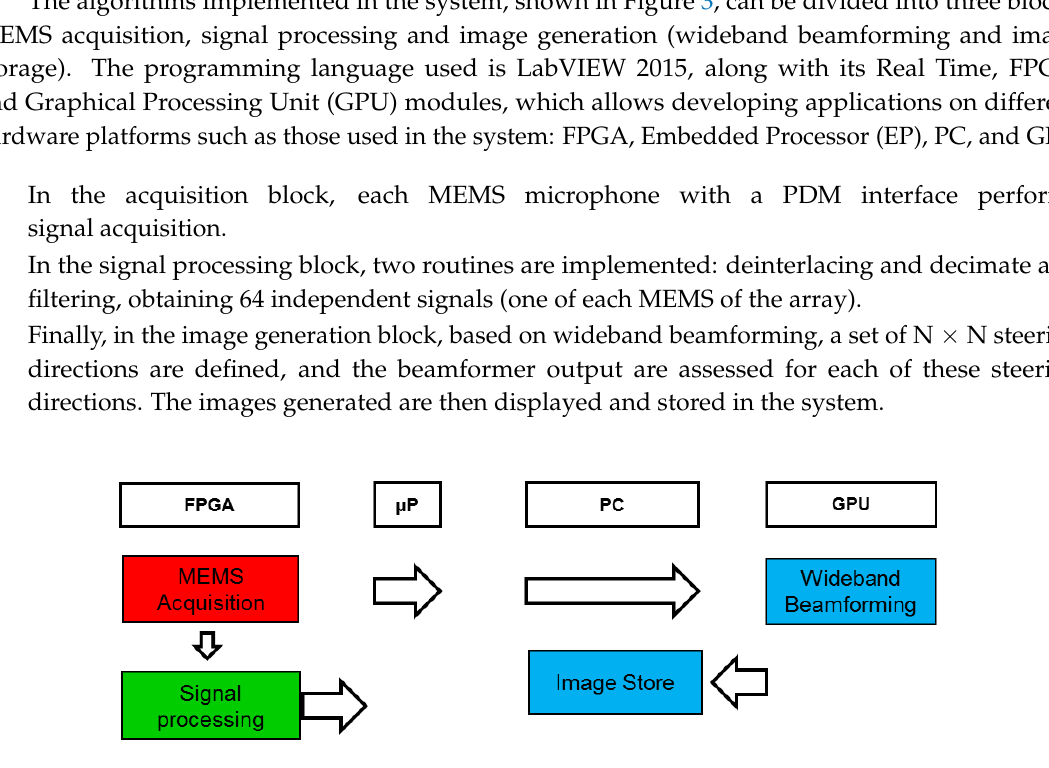
Figure 3. System framework. Figure 3. System